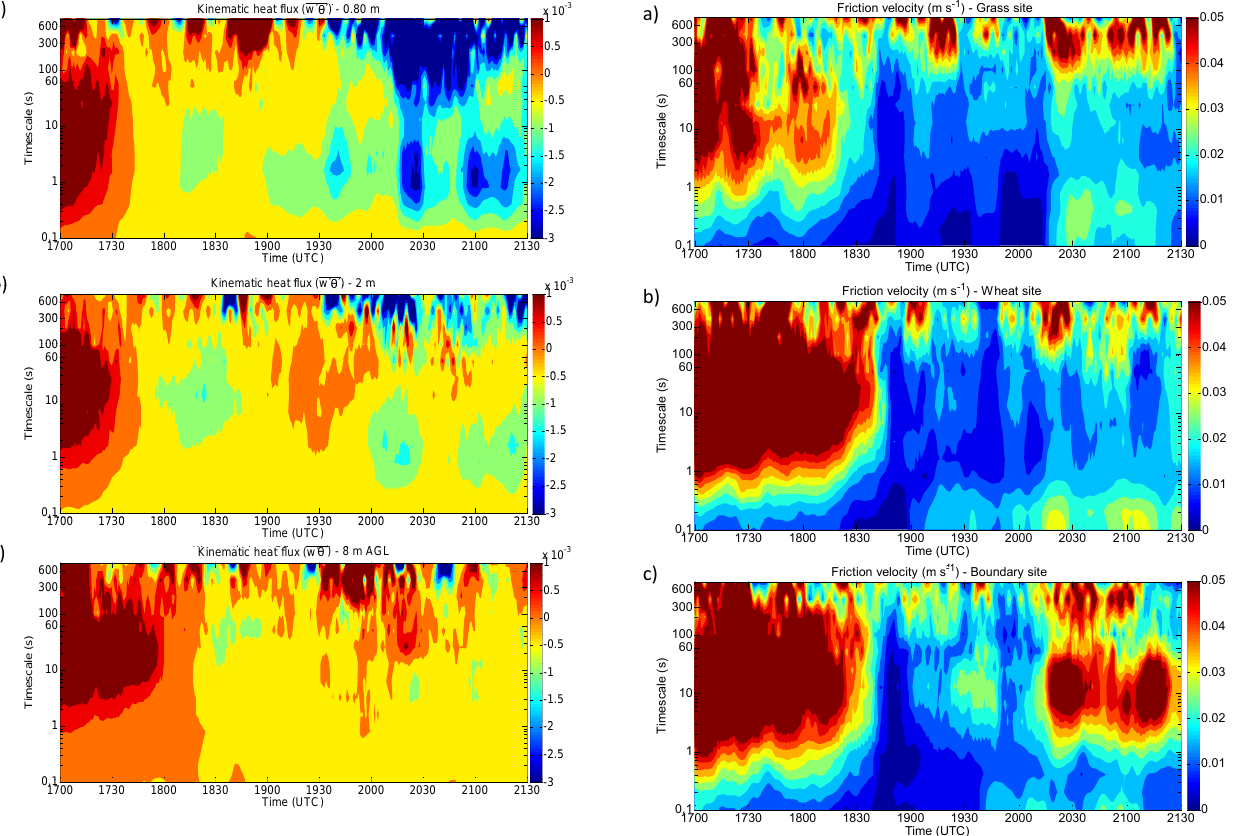
Figure 11. Multi-resolution flux decomposition (MRFD) of the fric- tion velocity (ms − 1 ) at grass (a) , wheat (b) and boundary (c) sites (located at the edge area and at